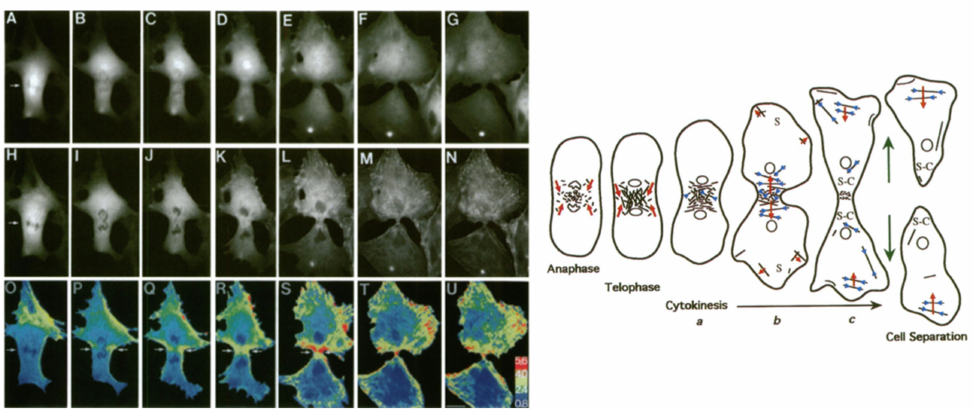
Figure 6. Myosin II dynamics in cytokinesis. ( A )–( G ), ( H )–( N ) and ( O )–( U ) represent the same time sequence for a volume fluorescence probe (top), Myosin fluorescence (middle) and Myosin II concentrations (in pseudocolor, bottom). They show a dramatic increase at the cleavage furrow, supporting a cortical flow/solation-contraction coupling mechanism